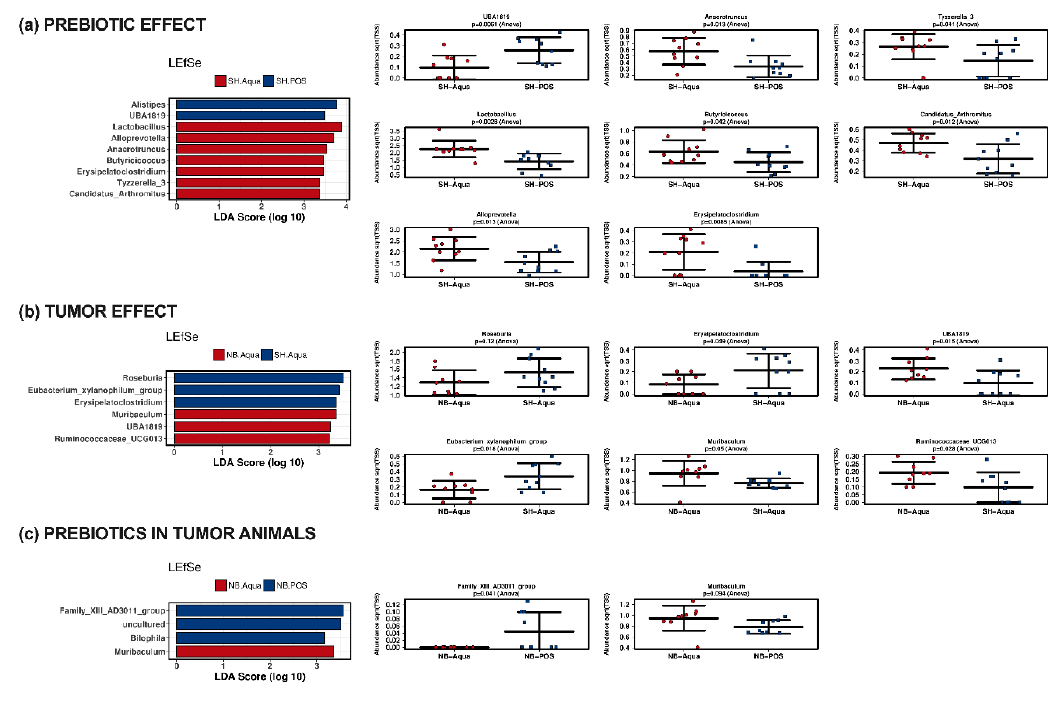
Figure 4. Linear discriminant e ff ect size (LEfSe) analysis examining the discriminating e ff ect of di ff erent bacteria regarding the e ff ect of ( a ) prebiotic supplementation, ( b ) the tumor, and ( c ) prebiotic gavage in tumor animals. Only bacteria with di ff erences between the groups corresponding to a p -value of < 0.1 are displayed as strip charts. NB—neuroblastoma; SH—sham; POS—prebiotic oligosaccharide.